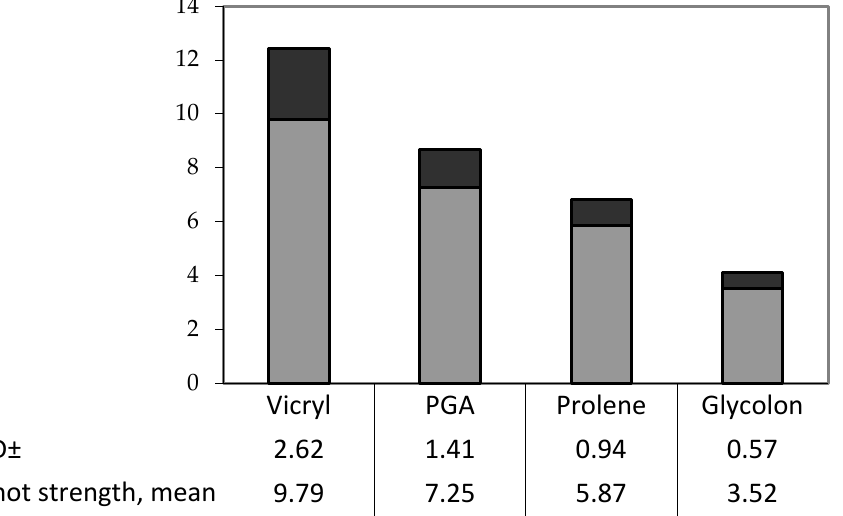
Figure 4. Diagram of the knot strength of each material in Newtons (mean ± SD).